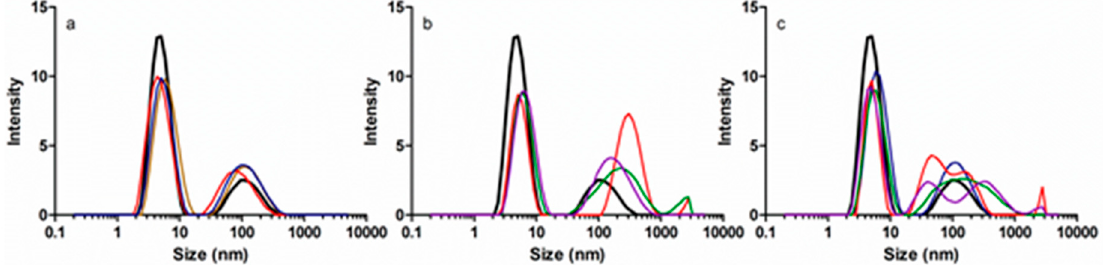
Figure 7. Dynamic light scattering (DLS) size distribution of (a) 5 μ M HSA titrated with 0 μ M (black), 25 μ M (yellow), 100 μ M (red), or 300 μ M (blue) PA; (b) 5 μ M HSA titrated with 0 μ M (black), 25 μ M (red), 50 μ M (green), or 125 μ M (purple) EGCg; (c) 5 μ M HSA (black) and HSA (5 μ M)-PA (300 μ M) titrated with 0 μ M (blue), 25 μ M (red), 50 μ M (green), or 125 μ M (purple) EGCg.